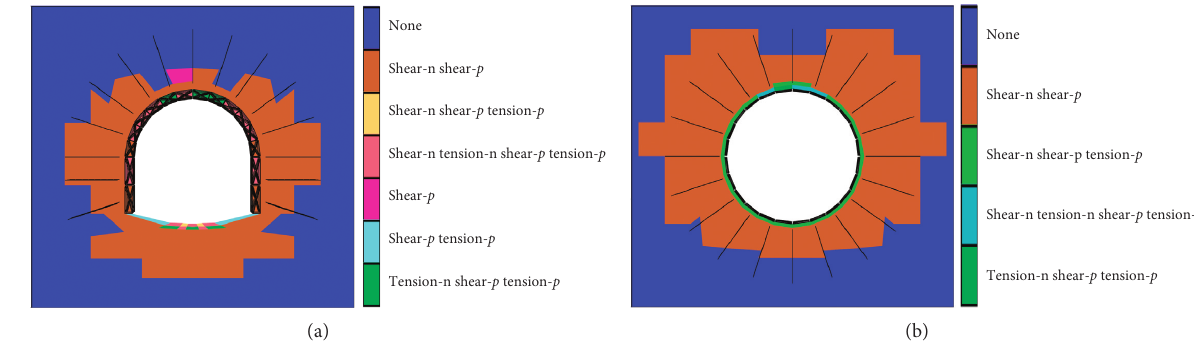
Figure 9: Yield zone distribution of roadway in excavation of 6m. (a) Semicircular arch roadway. (b) Circle